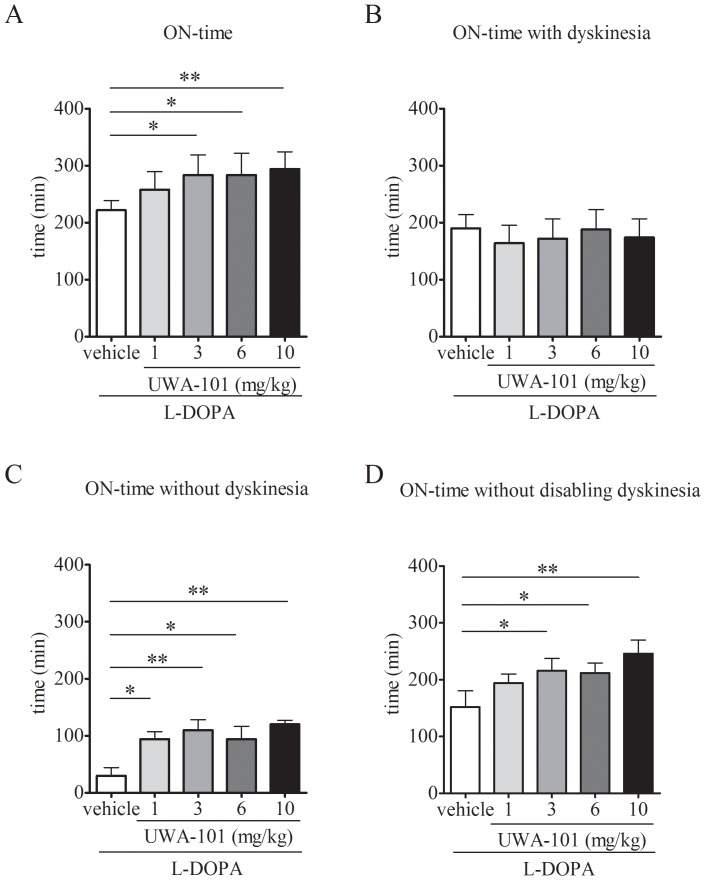
ON-time and quality of ON-time.A. UWA-101 (3, 6, 10 mg/kg), when co-administered with L-DOPA, significantly increased duration of ON-time compared to L-DOPA/ vehicle treatment. Following administration of L-DOPA/ vehicle, marmosets had a mean duration of ON-time of 221.8±19.0 min. Combining L-DOPA with UWA-101 3 or 6 mg/kg both led to an additional 62 min of ON-time, while UWA-101 10 mg/kg led to an additional 72.2 min of ON-time (all P<0.05). B. UWA-101 (1, 3, 6, 10 mg/kg), in combination with L-DOPA, did not alter duration of ON-time with dyskinesia. Following administration of L-DOPA/ vehicle, the mean duration of ON-time with dyskinesia was 190.0±26.9 min. This was not significantly modified when UWA-101 was added to L-DOPA (all P>0.05). C. UWA-101 (1, 3, 6, 10 mg/kg), in combination with L-DOPA, significantly increased duration of ON-time without dyskinesia. The administration of L-DOPA/ vehicle led to a mean duration of ON-time without dyskinesia of 30.0±15.8 min. When co-administered with L-DOPA, UWA-101 (1, 3, 6, 10 mg/kg) , increased duration of ON-time without dyskinesia by 64 min, 80 min, 64 min and 90 min, respectively (P<0.05 for UWA-101 1 and 6 mg/kg, and P<0.01 for UWA-101 3 and 10 mg/kg). D. UWA-101 (10 mg/kg) significantly extended duration of ON-time without disabling dyskinesia, when combined with L-DOPA. Following L-DOPA/ vehicle treatment, duration of ON-time without disabling dyskinesia was 152.0±32.1 min. The co-administration of UWA-101 10 mg/kg added 94 min (P<0.01). *: P<0.05; **: P<0.01. Data are expressed as the mean ± SEM.